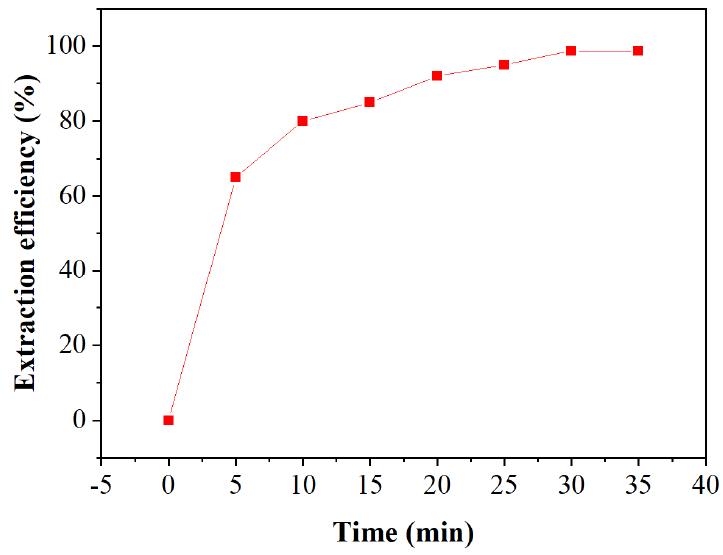
Figure 8. Extraction efficiency under different extraction times.